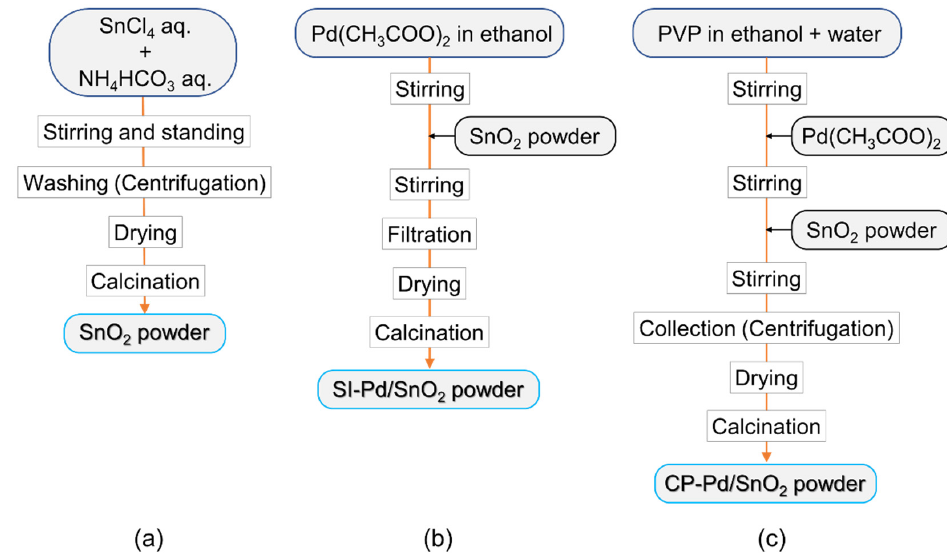
Figure 1. Flow chart of ( a ) the SnO 2 preparation process, and Pd loading procedures based on the ( b ) surface immobilization and ( c ) colloidal protection methods. ( b ) surface immobilization and ( c ) colloidal protection